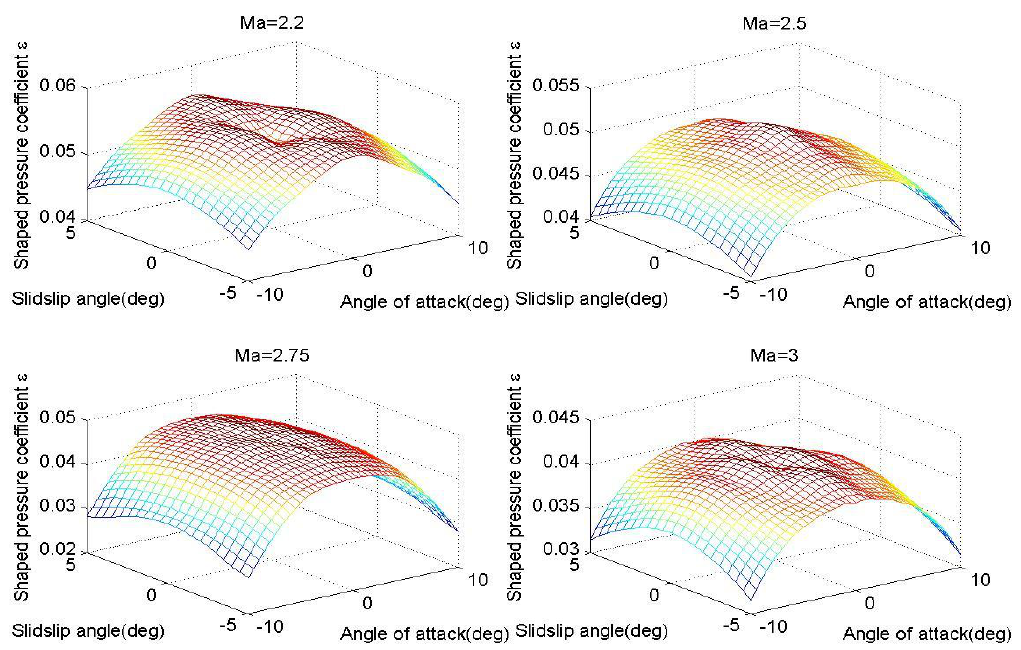
Figure 3. Change curves of shaped pressure